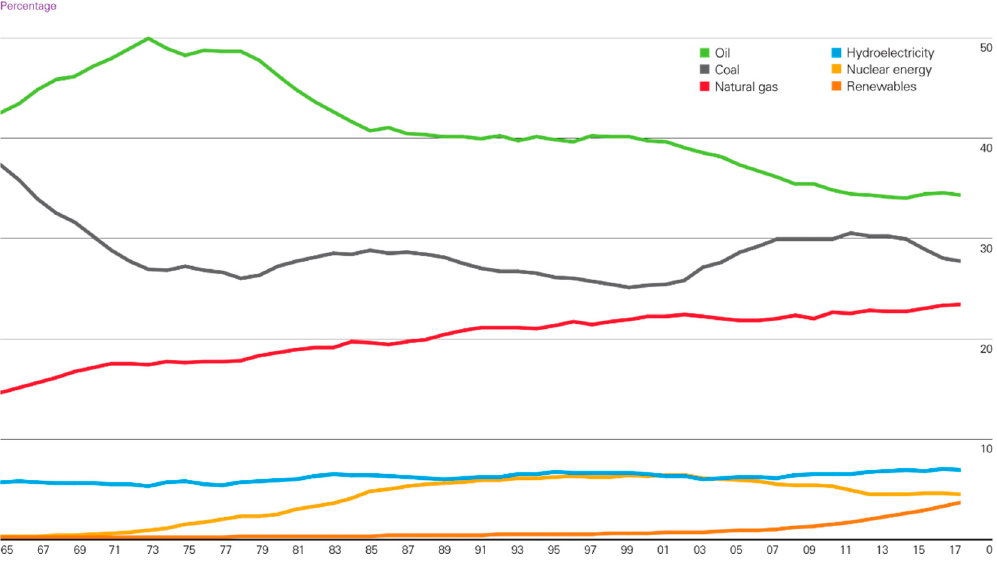
Figure 1. Shares of global primary energy consumption by fuel [6].